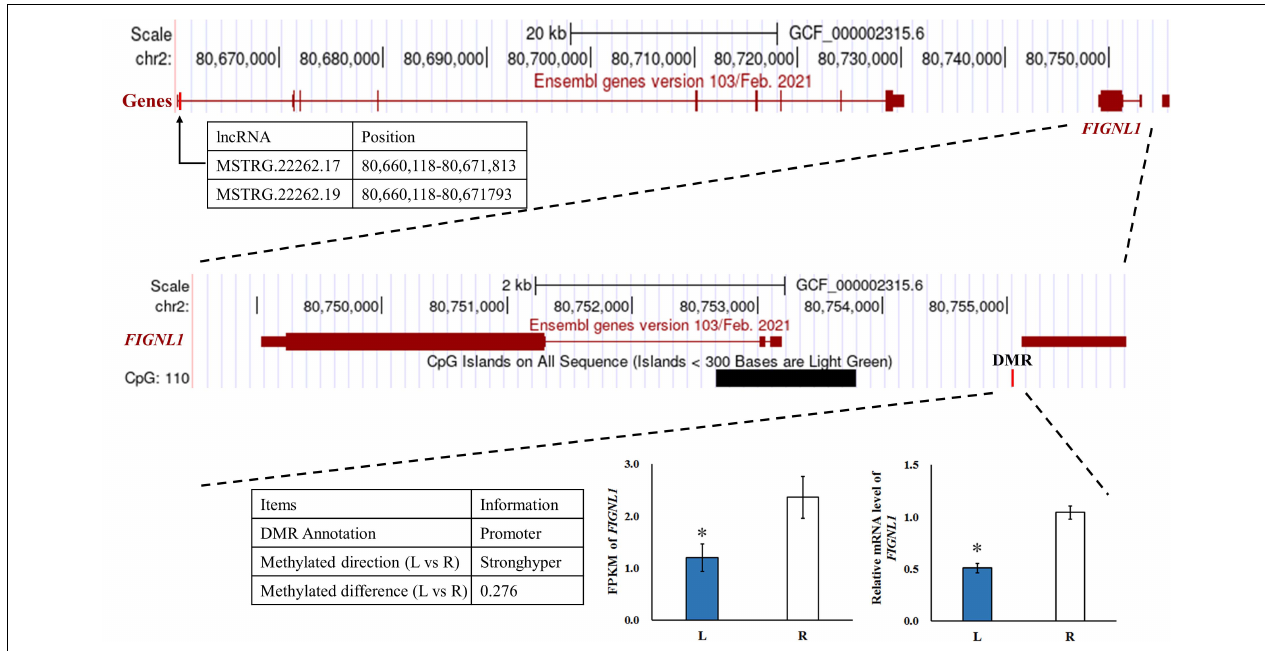
FIGURE 9 | The genome browser track plot around the FIGNL1 locus. The qRT-PCR was performed to detect the relative mRNA expressions in the left-side (affected-side; L) and the right-side (normal-side; R) mandibular condyle of crossed beak chicks of 7 days-old age with left mandibular curvature. GAPDH was used as internal control. Values are expressed as means ± standard deviation of four replicates. The expression data were analyzed using t -test, *represents p <